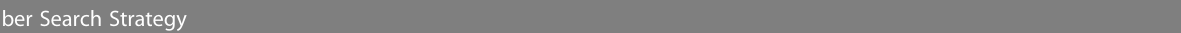
TABLE 1 Search strategy of PubMed. Number Search